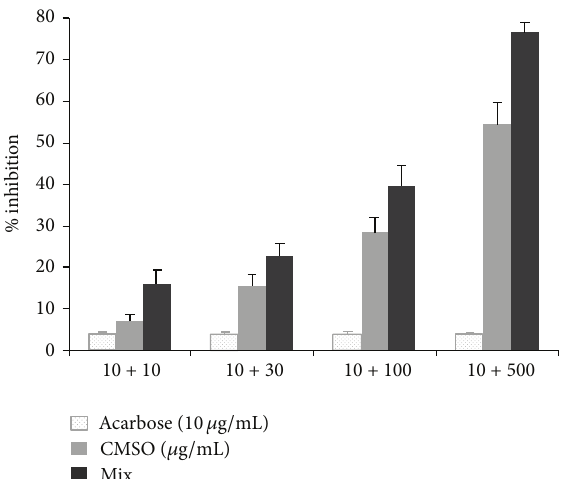
Figure 1: 𝛼 -Glucosidase inhibitory effect of Buddha’s hand essential oil (10–500 𝜇 g/mL) and in combination with acarbose (10 𝜇